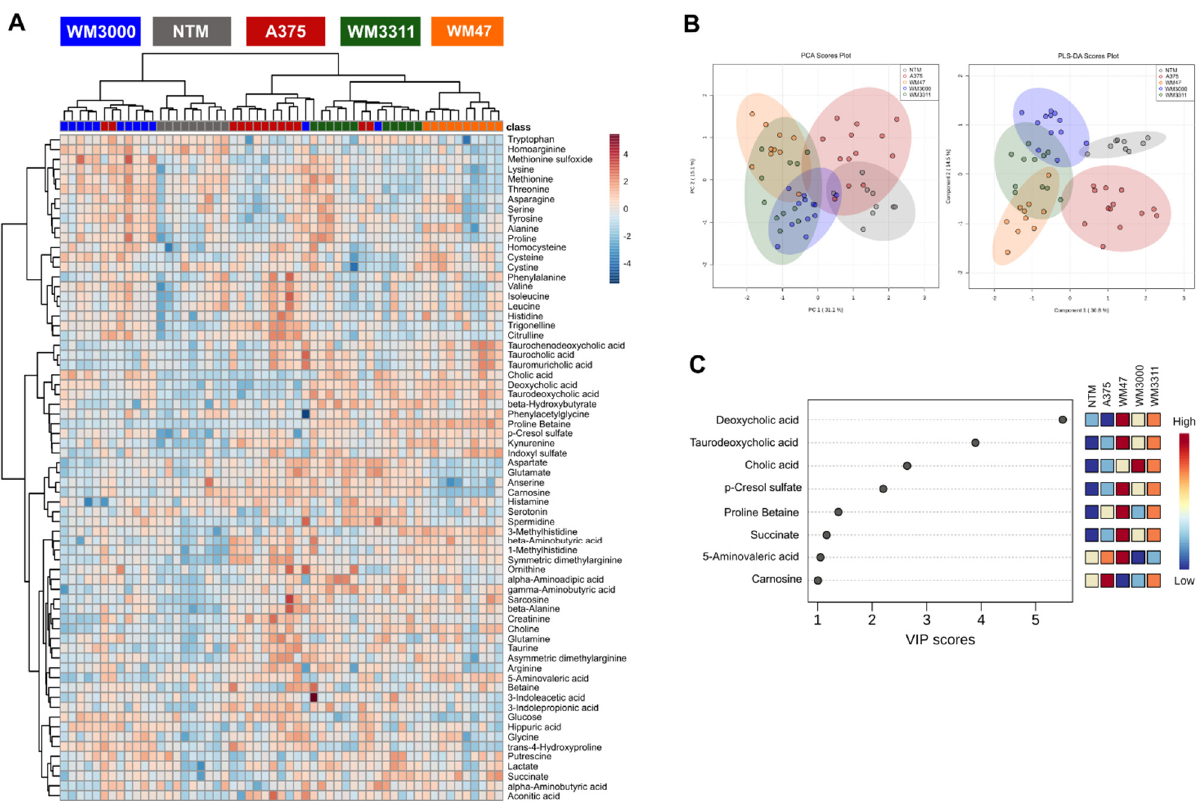
Figure 5. Metabolic analysis of hydrophilic/polar metabolites in plasma. ( A ) Heatmap, ( B ) PCA and PLS-DA scores, and ( C ) PLS-DA VIP score derived from the hydrophilic/polar metabolite profiling data of plasma samples from mice bearing A375, WM47, WM3000, and WM3311 melanoma xenografts and non-tumor mice (NTM); n = 9–13.